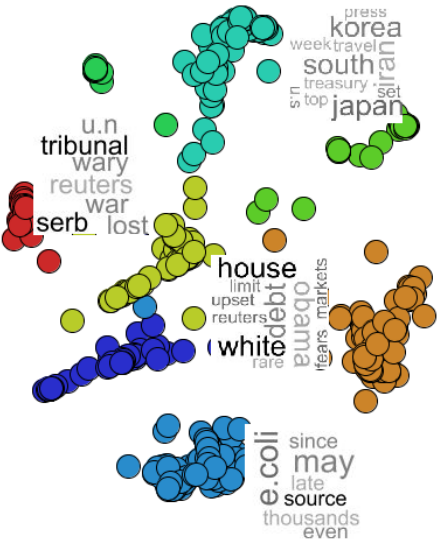
Figure 4. Interaction tool: the tag cloud of a document is shown when passing the mouse over a point.